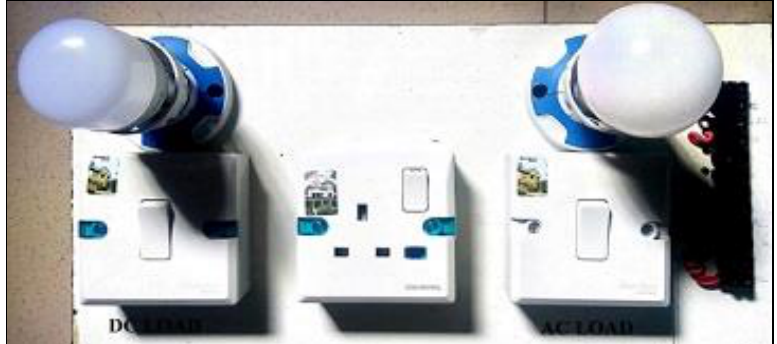
Figure 5: Hybrid Load on Wooden Board when Not Powered.